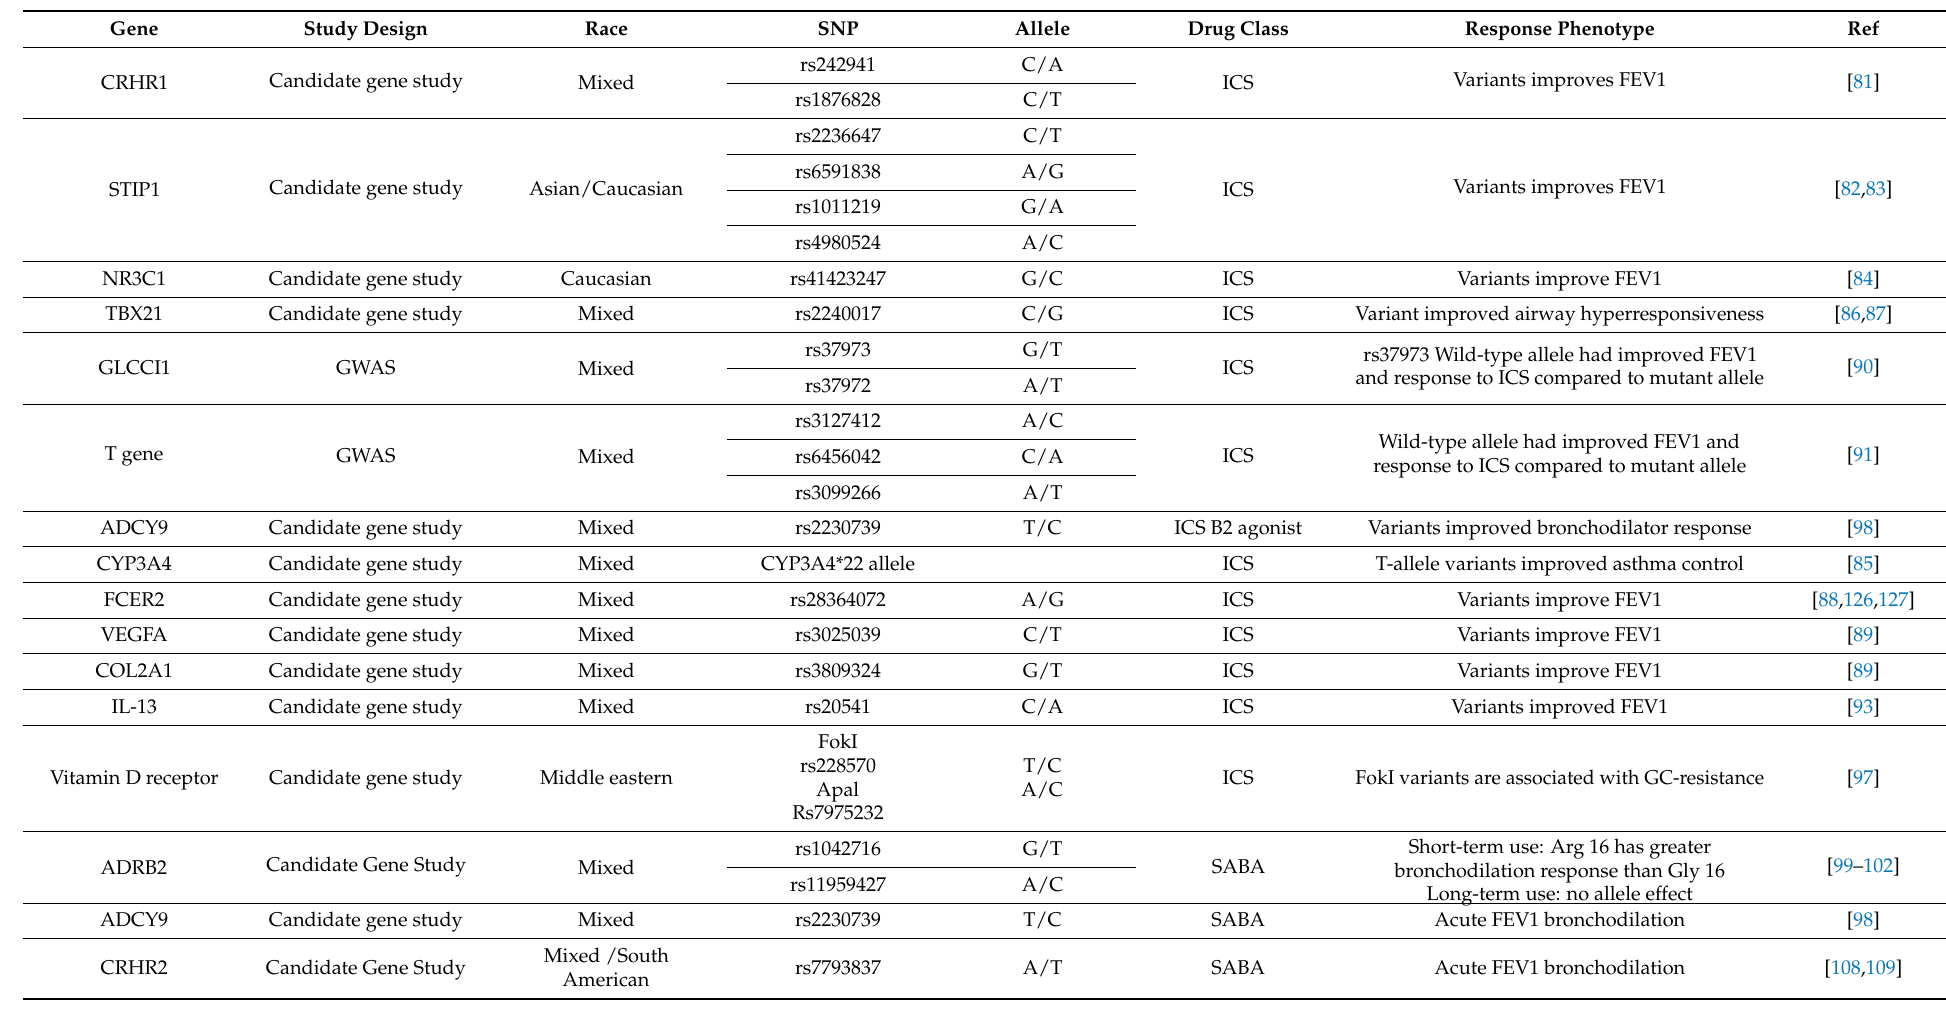
Table 2. Single Nucleotide polymorphisms associated with treatment